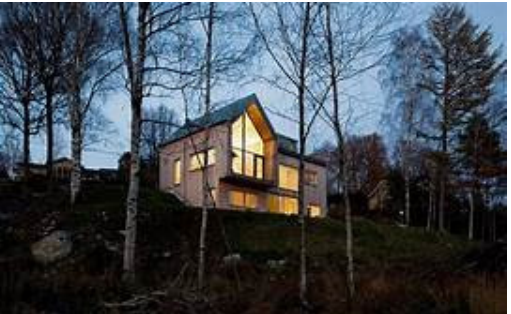
Figure 13. This house is incorporated into the surrounding hillside, which reduces energy usage.